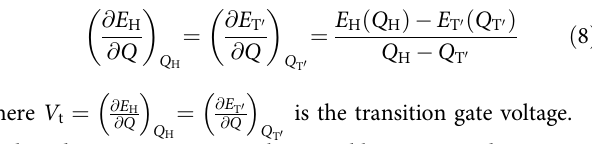
Plotted in Fig. 4c is the equilibrium grand potential (equation 5) as a function of the gate voltage. Two transition voltages are labelled also using black dashed lines. Figure 4b,c